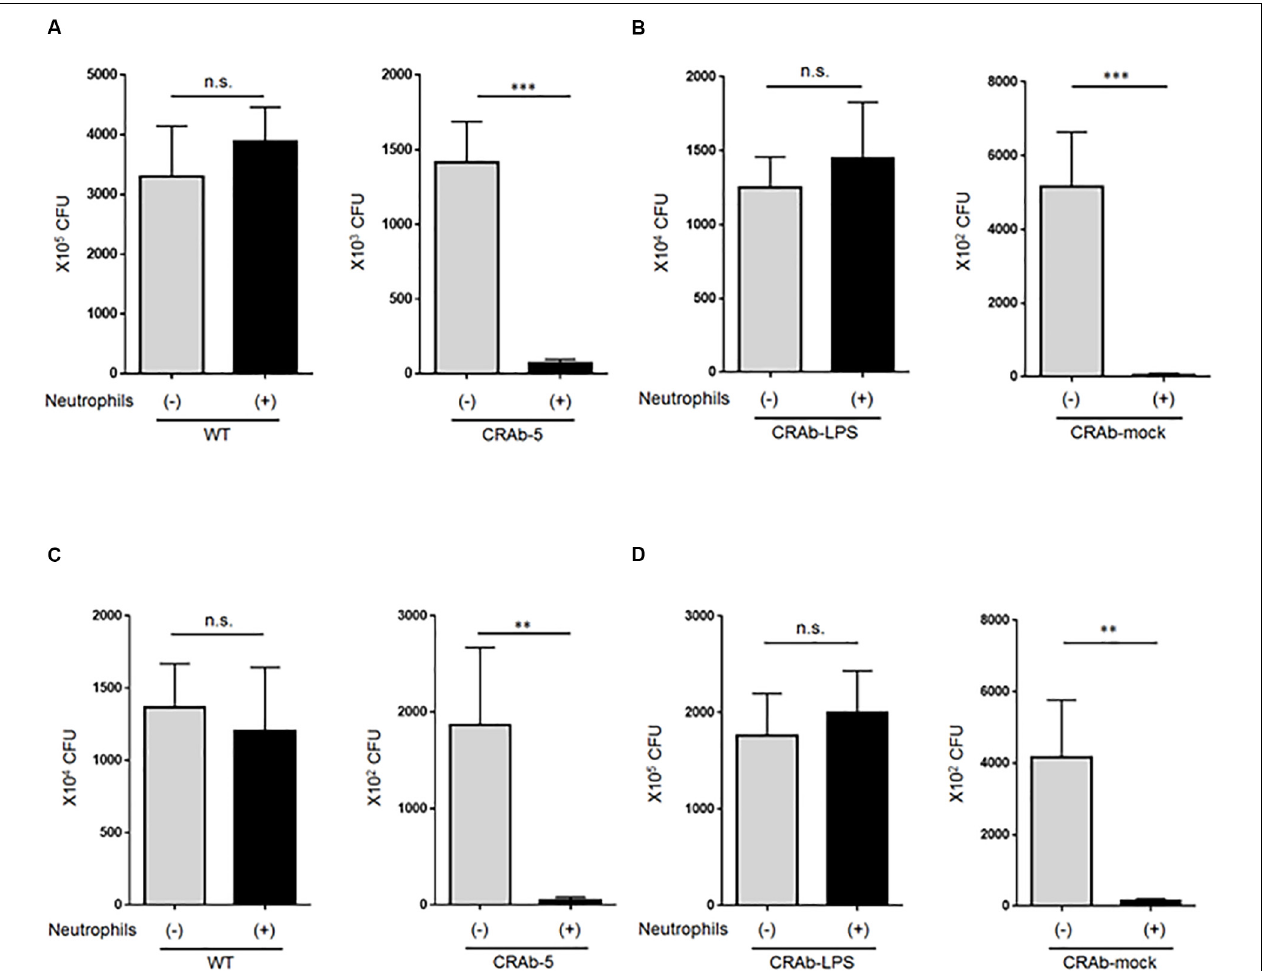
FIGURE 4 | Assay of lipopolysaccharide-deficient Acinetobacter baumannii strain clearance by neutrophils. (A) ATCC 19606 (WT), colistin-resistant A. baumannii (CRAb-5), (B) CRAb-LPS, or CRAb-mock and neutrophils were co-cultured for 4 h. Surviving bacteria were then counted. In panel (C) , cytochalasin B was used to inhibit neutrophil phagocytosis in co-cultures. Clearance capacity of 4-h neutrophil/CRAb-5 co-culture supernatant was evaluated by adding supernatant to CRAb-LPS or CRAb-mock and incubating for 4 h. Viable cells were then counted by plating on kanamycin agar (D) . Data are means ± SD; n = 6 per group. n.s., not significant, ∗∗∗ P < 0.001, ∗∗ P < 0.01. Means are representative of three experiments.